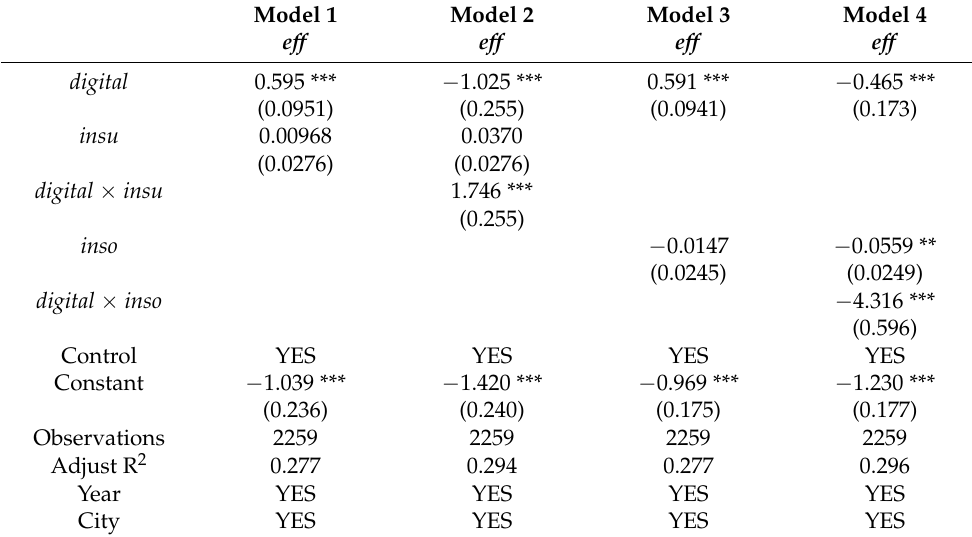
Table 8. Moderating effect regression results.